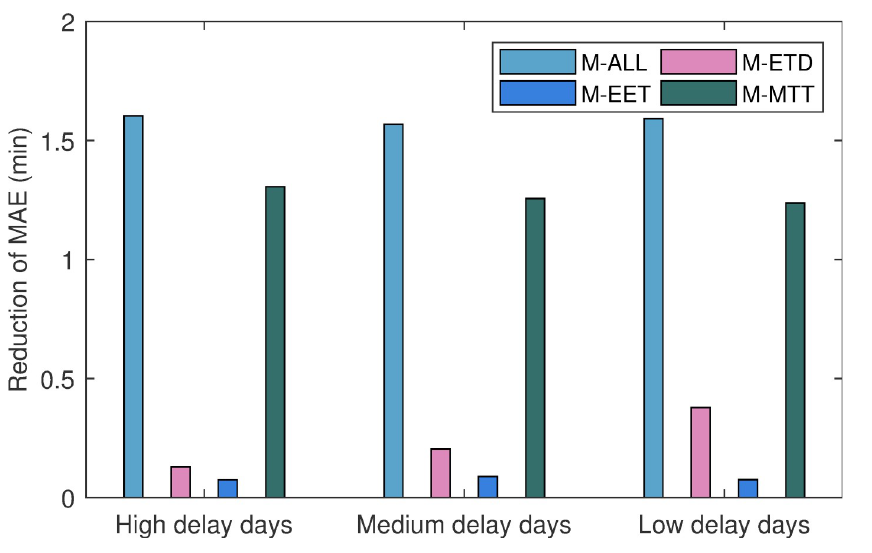
Fig 8. The contribution of the parameter methods.